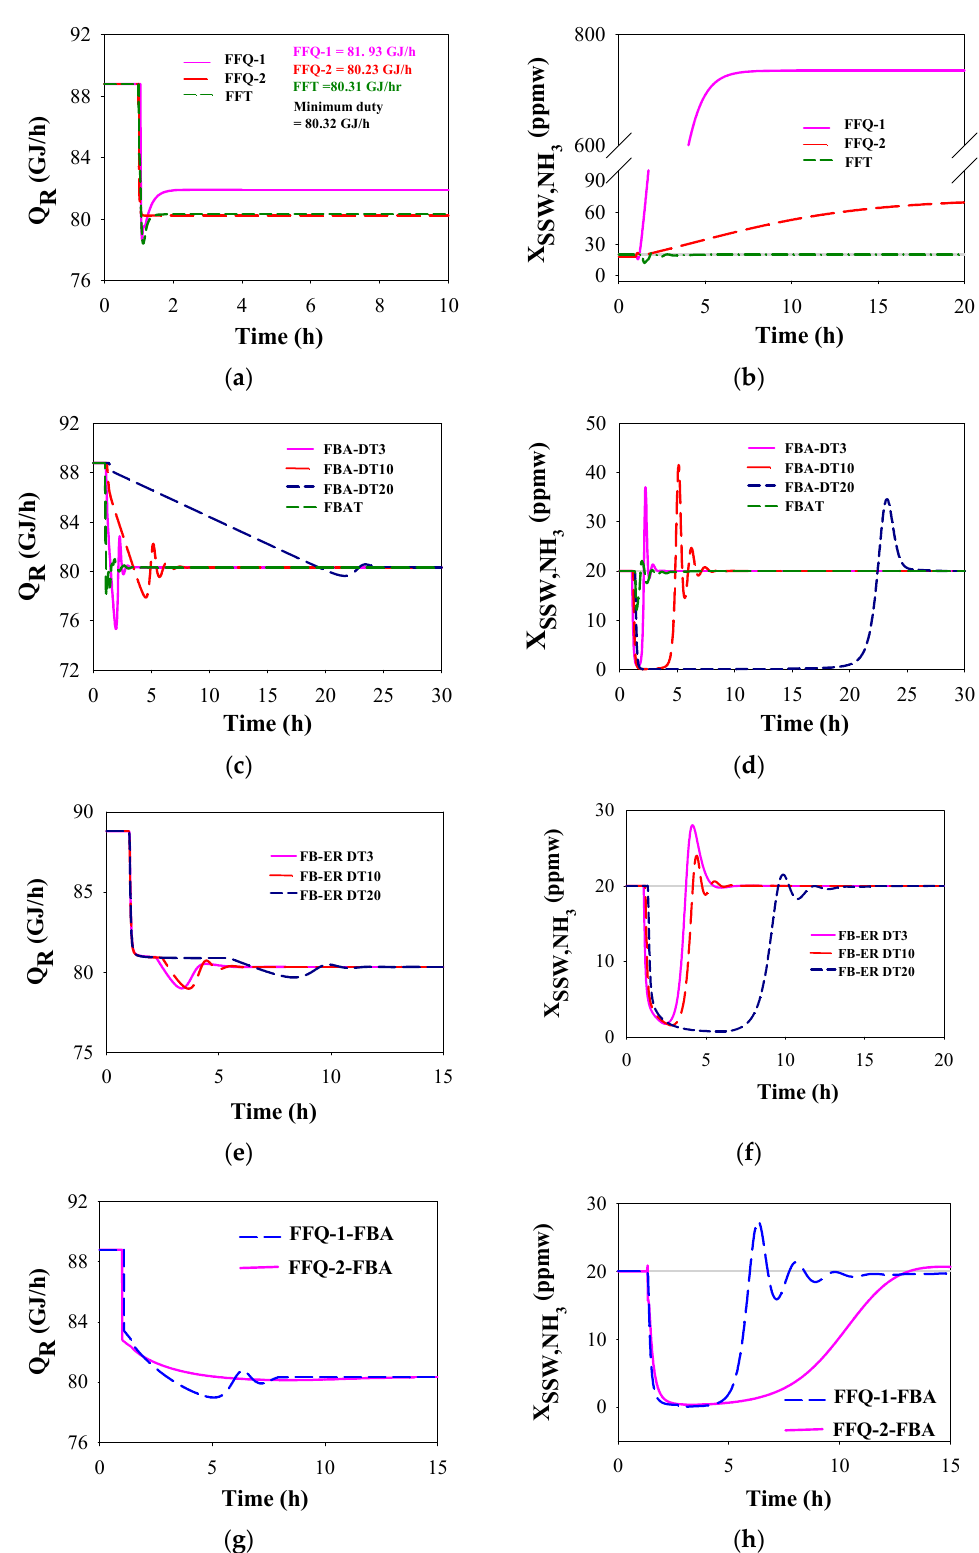
Figure 8. The dynamic responses (reboiler duty and stripped sour water (SSW) NH 3 concentration) of the sour water stripper (SWS) employing different control schemes to the sour water feed flowrate disturbance with − 10% change, ( a , b ) for feedforward control, ( c – f ) for feedback control, ( g , h ) for feedforward-feedback